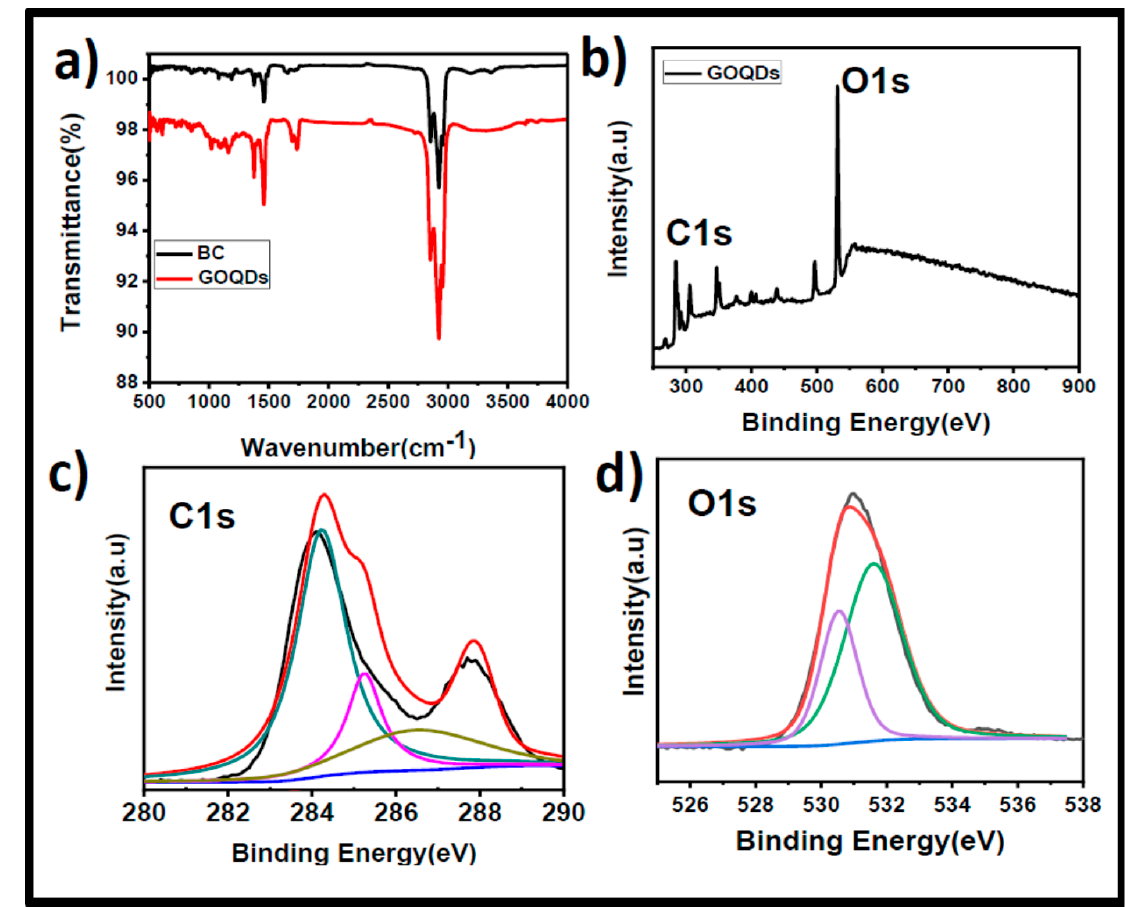
Figure 3. ( a ) FTIR spectra of synthesized GOQDs. ( b ) XPS survey spectrum of GOQDs. ( c ) C1s deconvolution XPS spectra of GOQDs. ( d ) O1s deconvolution XPS spectra of GOQDs. The black color line is for the original spectrum and the other colored lines are the deconvoluted spectral lines in both subfigures c and d.